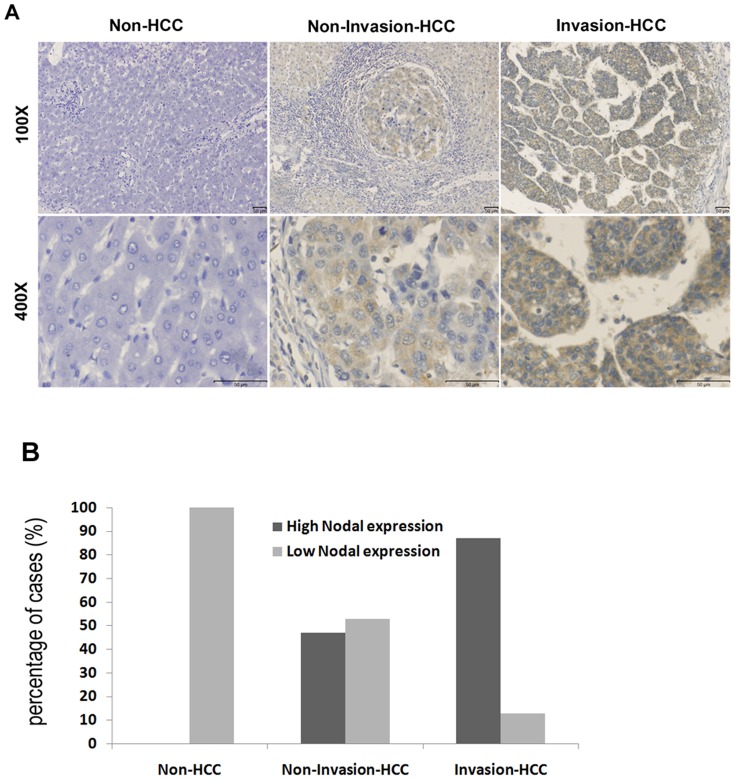
Immunohistochemical staining of Nodal in HCC tissues and non-HCC tissues.(A) Representative images from immunohistochemistry analyses of Nodal expression in normal liver tissue (Non-HCC), HCC without invasion tissue (Non-Invasion-HCC) and HCC with invasion tissue (Invasion-HCC). (B) Percentages of high Nodal expression in Non-HCC cases, Non-Invasion-HCC cases and Invasion-HCC cases.